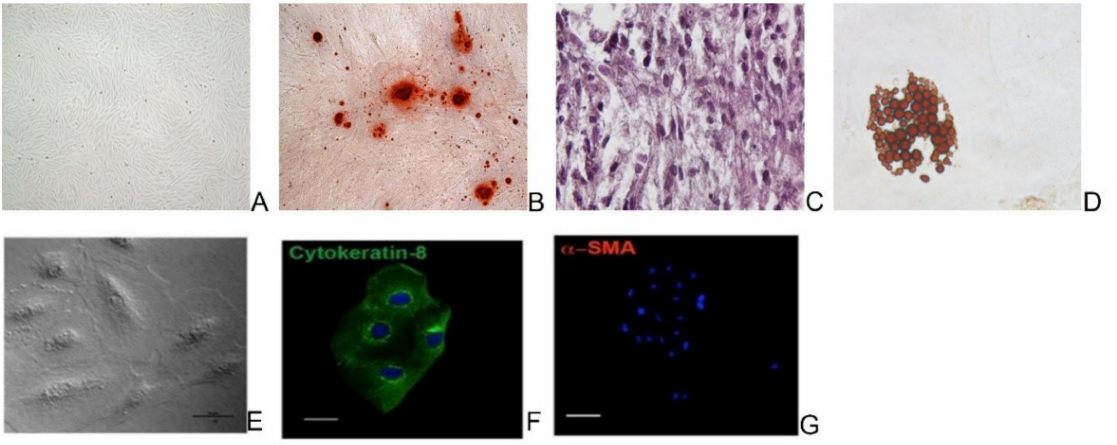
Figure 2. Microscopic images of sheep ADSCs cultured in normal ( A ), osteogenic ( B ), chondogenic ( C ), and adipogenic ( D ) media for the three lineages differentiation test. Magnification × 4. Representative images of in vitro cultured AECs displaying a polyhedral phenotype (phase contrast) ( E ), cytokeratin 8 positivity (green color) ( F ), and alpha SMA negativity ( G ). Nuclei were counterstained with DAPI (blue color). Scale Bars: 10 µ m for phase contrast and cytokeratin 8 images, and 50 µ m for alpha SMA